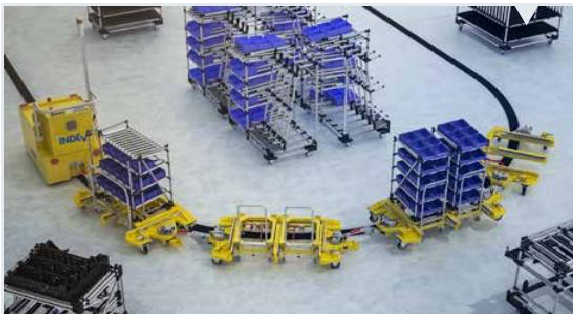
Figure 1: Set with AGV towing vehicle within the system